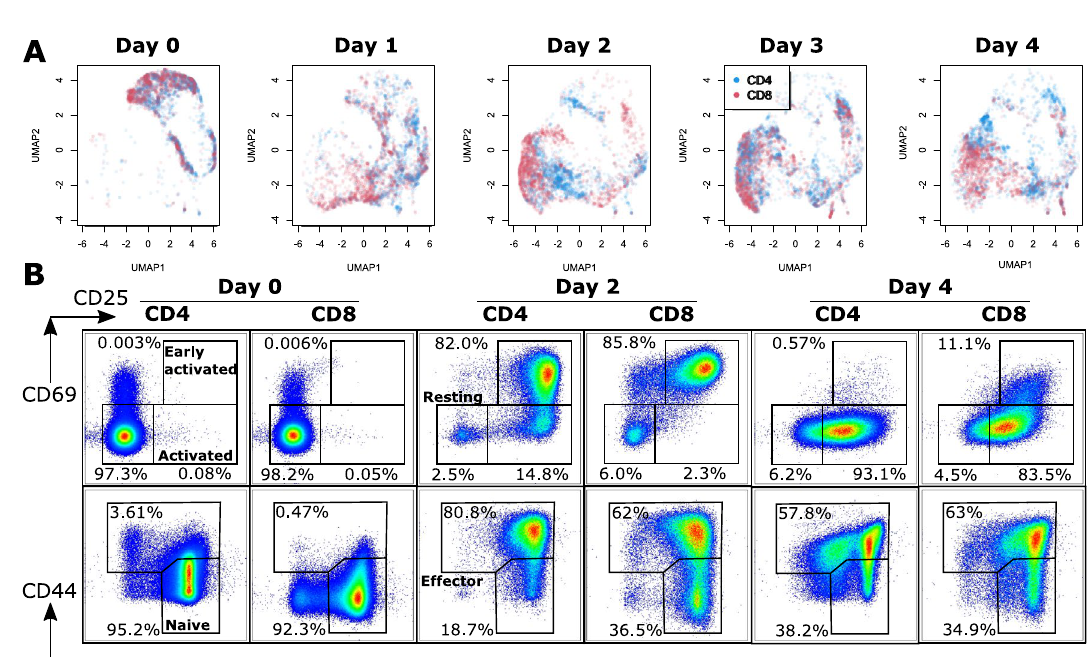
Figure 3. Cellular evolution over 5 days upon activation. ( A ) UMAP plots of T cells stimulated across several days, displayed separated by day. ( B ) Parallel measurements of the expression of surface markers for activation (CD25/CD69) and early differentiation (CD44/CD62L) separated per day, with cell types, and corresponding FACS panel showing activation/differentiation. The results are representative of at least three